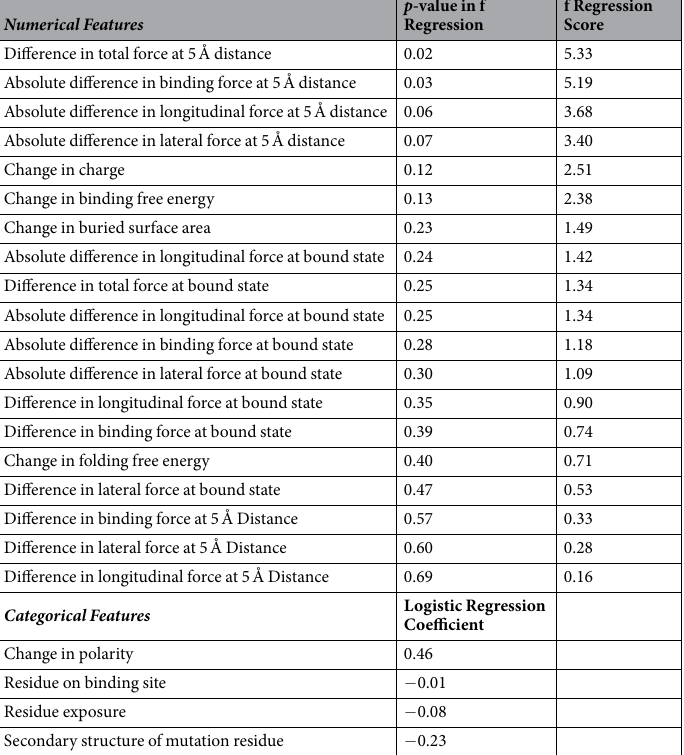
Table 3. Statistical analysis of 23 possible